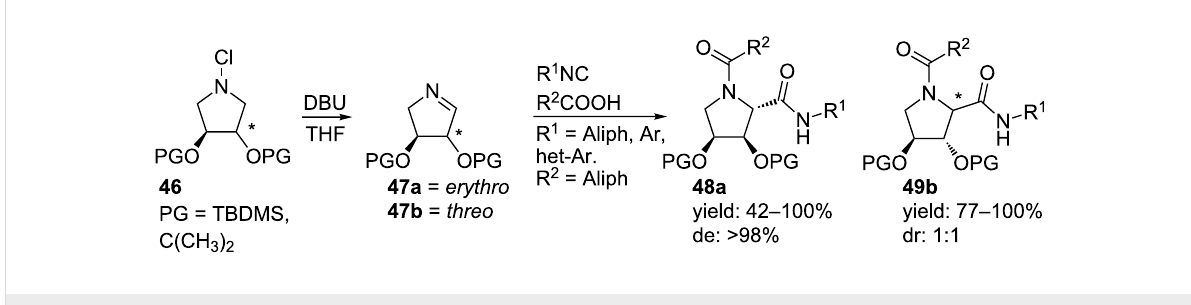
Scheme 15: Dihydroxyproline derivatives from an Ugi reaction.